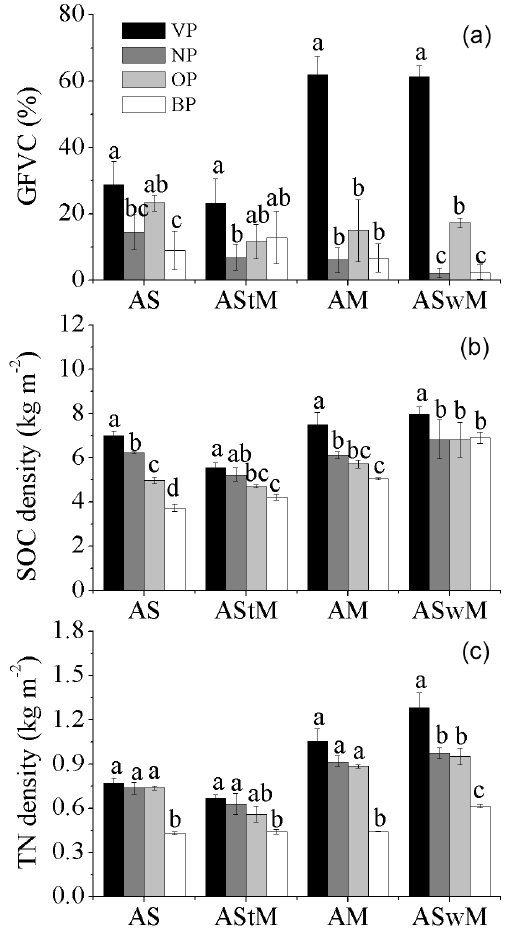
Figure 6. Green fractional vegetation cover (GFVC, %; a ) soil organic carbon density (SOC, kgm − 2 ; b ) and total soil nitrogen density (TN, kgm − 2 ; c ) of vegetation patch (VP), new pika pile (NP), old pika pile (OP), and bald patch (BP) at a quadrat scale of four types of alpine grasslands (see Fig. 1). Error bar indicates ± standard deviation and different letters above the error bar indi- cate significant differences among surface types ( p